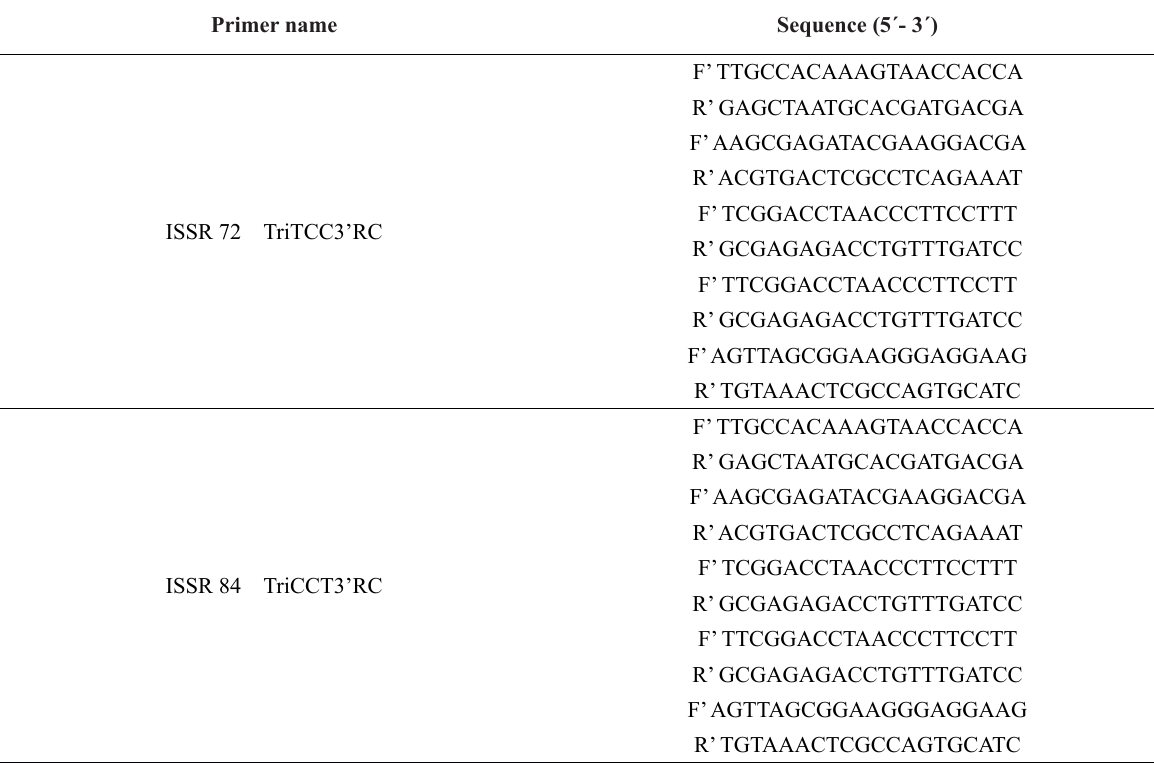
Design of new primers/ SCAR molecular markers to be tested and validated for association with fiber quality in